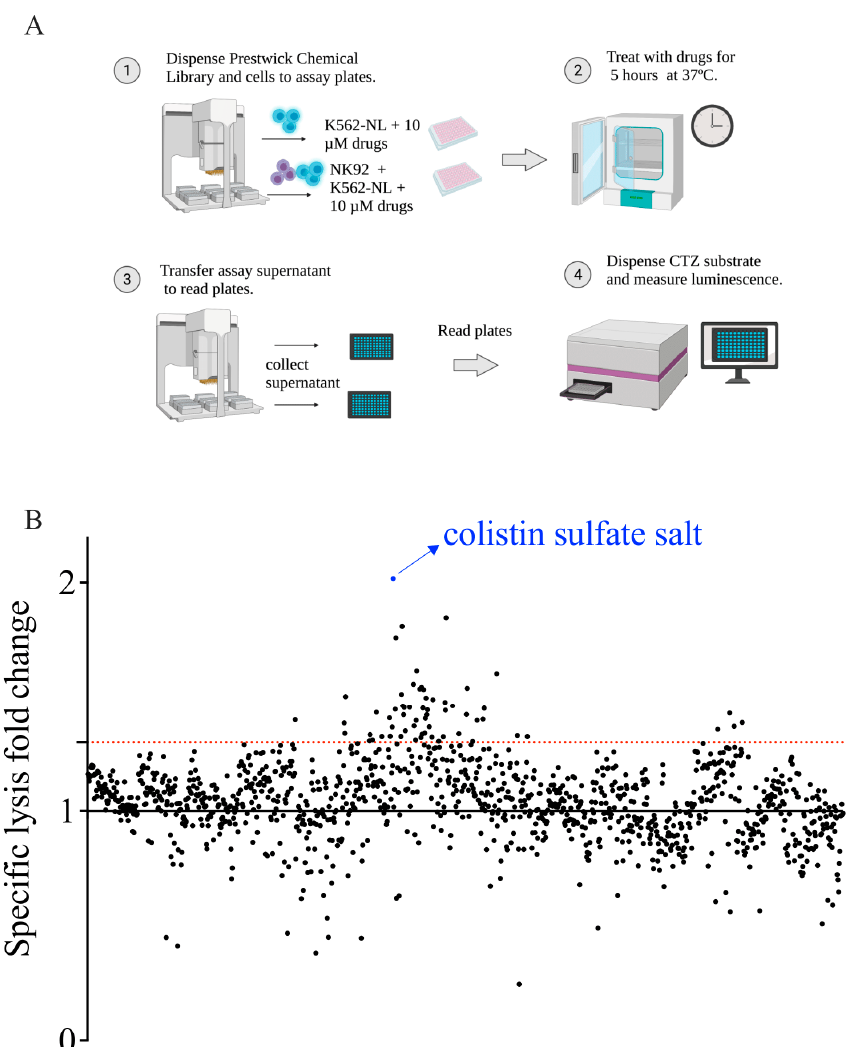
Figure 2. Screening of the Prestwick Chemical Library. ( A ) Schematic workflow of the Prest- wick Chemical Library screening. ( B ) Average luminescent fold-change over DMSO control of all 1200 compounds from NK92 + K562-NL condition are plotted (each drug is represented by a black dot). The screening was conducted in singlet, over two biological replicates. The dotted red line indicates 1.3 fold-change. Compounds with a luminescent fold-change over DMSO control ≥ 1.3 were considered enhancers of NK92 cytotoxicity. Points represent the average fold-change of n = 2 biological replicates, except points 321–400 and 481–560 which represent fold-change from one